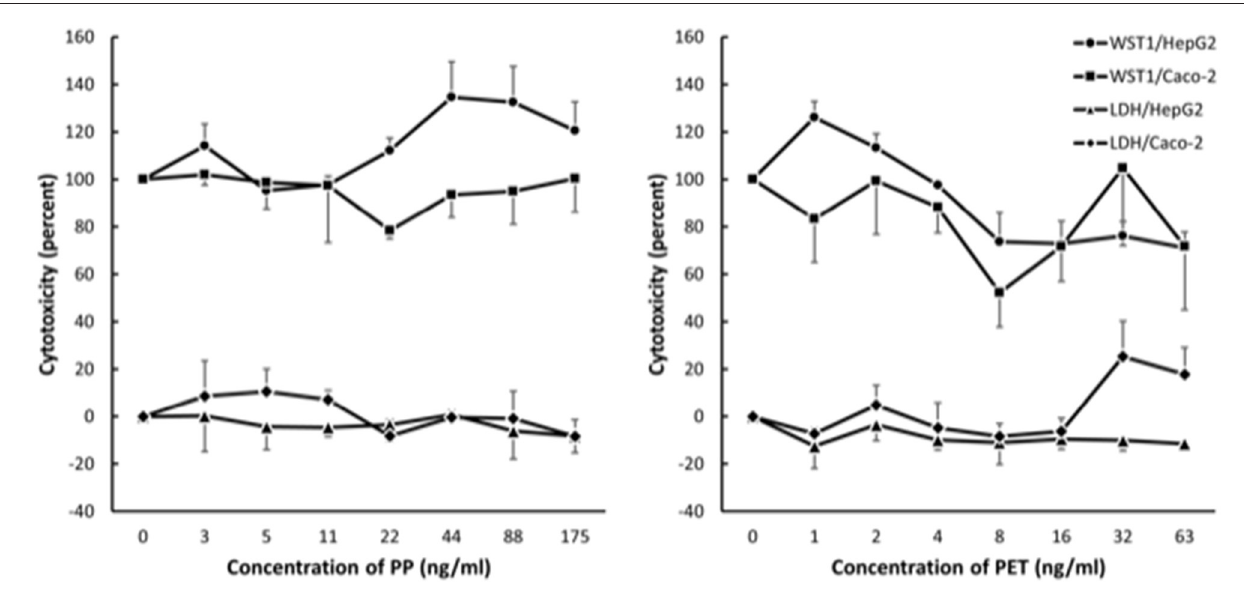
FIGURE 4 | Cytotoxicity in Caco-2 and HepG2 cells after 24h exposure to polypropylene (PP) and polyethylene terephthalate (PET). The results are reported as fold-difference compared to the positive control (LDH assay) and unexposed (WST-1 assay). Symbol and error bars are means and SEM from three independent experiments.